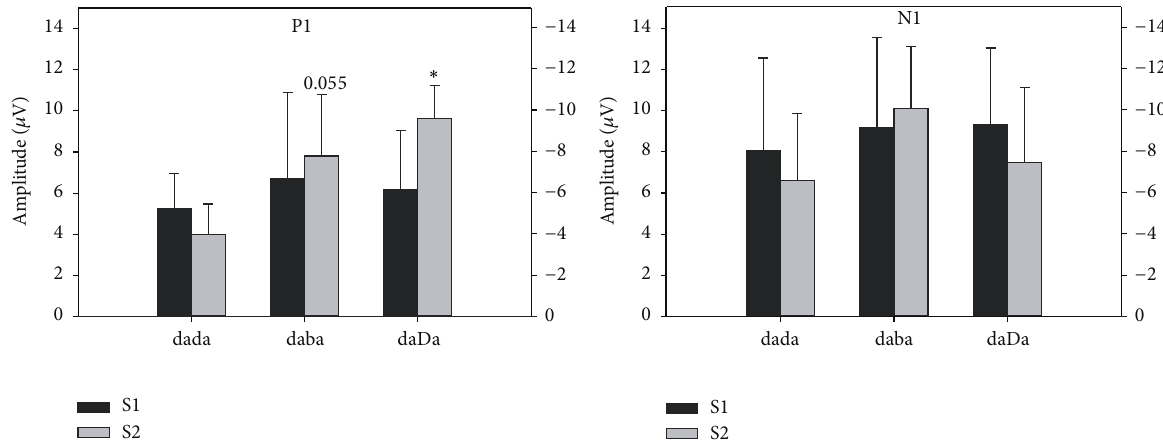
Figure 6: Infant: baseline-to-peak amplitude of the P1 and N1 components elicited to the S1 and S2 portion of the /dada/, /daba/, and /daDa/ stimulusconditionsisshown.Anasterisk( ∗ )denotesthestatisticalsignificanceofresults( 𝑝 < 0.05 );“0.055”denotesa p valuethatapproached significance.